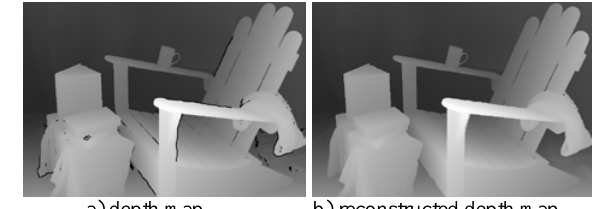
Fig. 5. Architecture of the neural network.